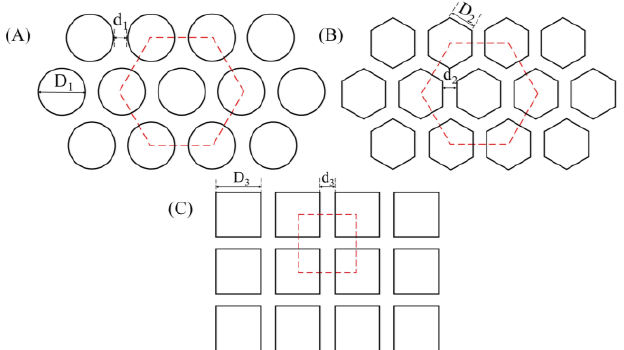
Figure 1. The arrangement diagram of the special-shaped microlens array mold. ( A ) the circular, ( B ) the hexagonal, and ( C ) the square MLAs.